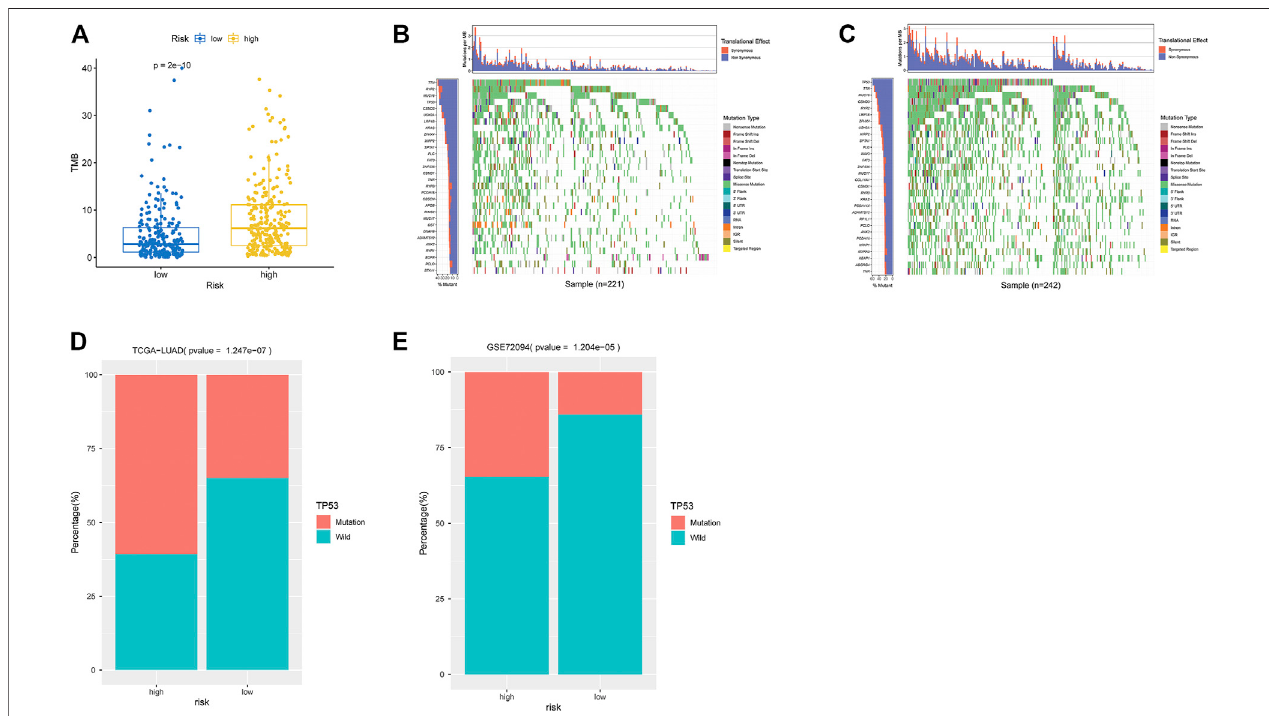
FIGURE 5 | Analysis of TMB and mutation genes. (A) Box plot of TMB differences in high- and low-risk groups in TCGA-LUAD dataset. Blue: low-risk group. Yellow: high-risk group. (B) Waterfall plot of top30 genes in low-risk group in TCGA-LUAD. X-axis: samples; y-axis: top 30 genes. Different colors of modules represent different mutation types. (C) Waterfall plot of top 30 genes in the high-risk group in TCGA-LUAD. (D) Histogram ofTP53 mutation in high- and low-risk groups in TCGA- LUAD. X-axis: TP53-mutation and TP53-wild in two groups. Y-axis: sample number. (E) Histogram of TP53 mutation in two groups of GSE72094 validation set.